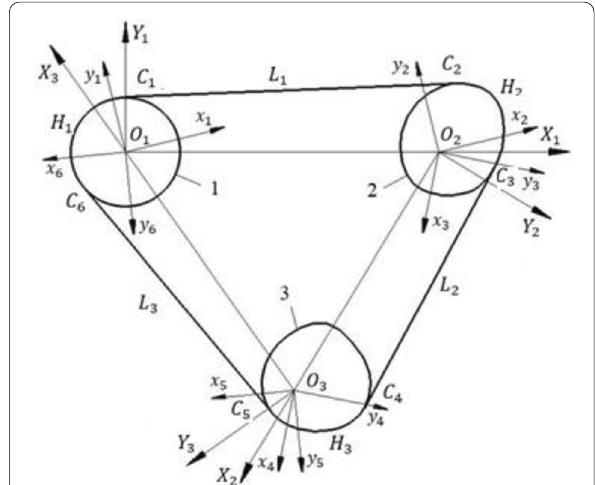
Figure 3 Schematic diagram of coordinate system of noncircular three-pulley synchronous belt transmission mechanism and calculation of belt length: 1. Driving pulley, 2. Driven pulley, 3. Tension